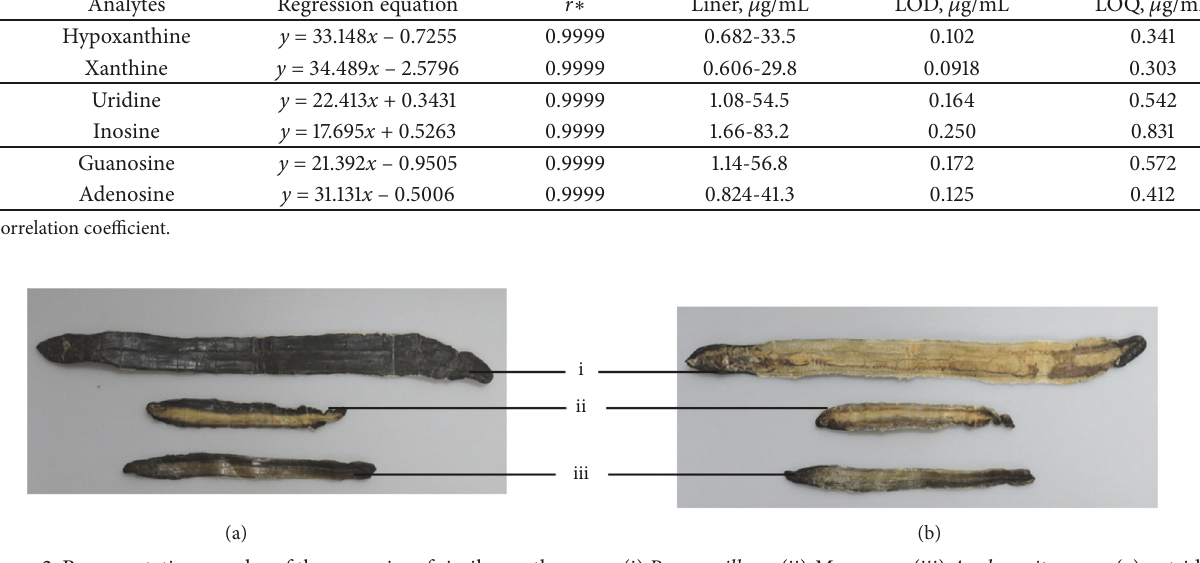
Figure 2: Representative samples of three species of similar earthworms. (i) P. aspergillum ; (ii) M. magna ; (iii) A. obscuritoporus ; (a) outside; (b)